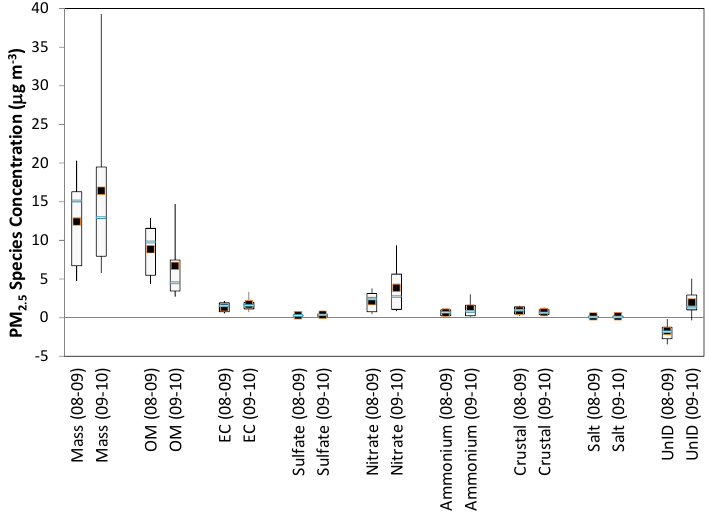
Fig. 5. Concentrations of PM 2 . 5 mass and major constituents (i.e., square: average; bar: median; box: 25th and 75th percentiles; whiskers: 10th and 90th percentiles) for winter 2008/2009 and 2009/2010. UnID is the unidentified mass (i.e., measured minus reconstructed PM 2 . 5